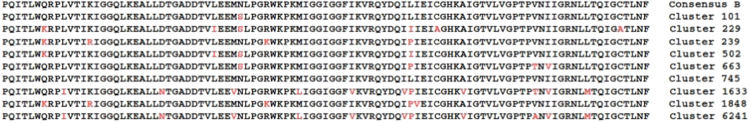
Some sequence groups of the HIV-1 protease data set (see [1]).